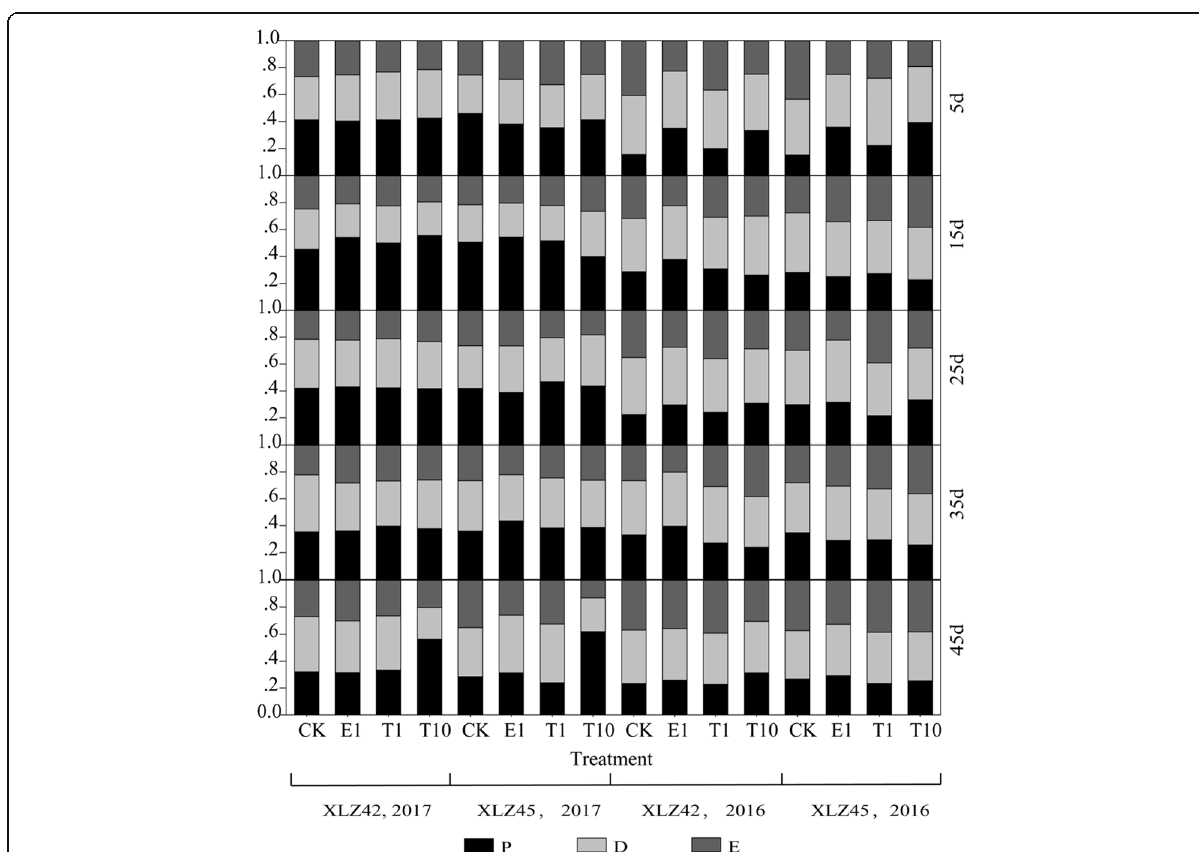
Fig. 8 Absorbed light dissipation of two cotton varieties (XLZ42 and XLZ45) at different days since flowering in various treatment groups: 1 and 10 days before the first irrigation (T1, T10, respectively) and 1 day before the second irrigation (E1) after seedling emergence, during 2016 – 2017. The control group (CK) had film mulching throughout the growth stages. D, portion of absorption light energy lost via the PS-II antenna pigment; P, actual photochemical quantum yield of PS-II; E, portion of absorption light energy which cannot enter the photochemical process and cannot be lost through the antenna